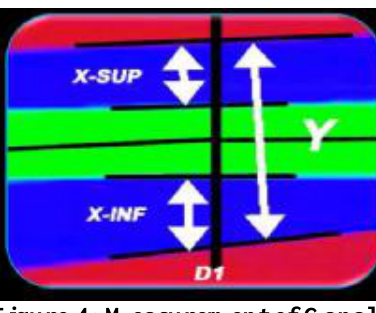
Figure 4: Measurement of Canals.